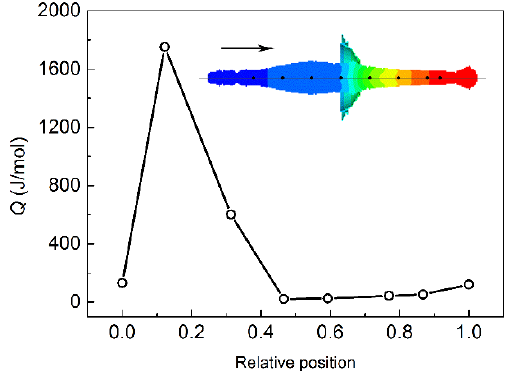
Figure 23. The varying of material strain rate during jet forming of Mo-10Ta.